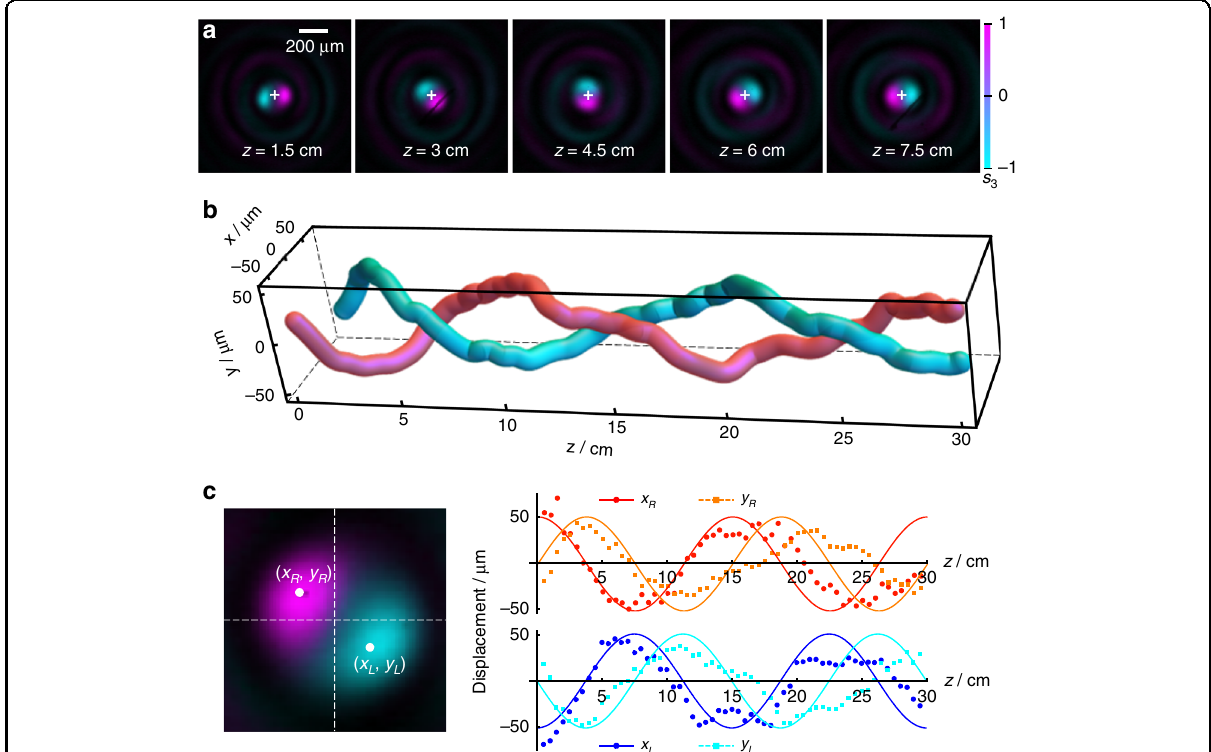
Fig. 4 Spiral-like PSHE of Bessel beam. a Transverse pro fi les of the optical fi elds at different distances, with the background color representing the Stokes parameter s 3 . b Measured trajectories of the two spin states. c Displacements of the spin states vs. propagation distance, where the solid lines depict the theoretical